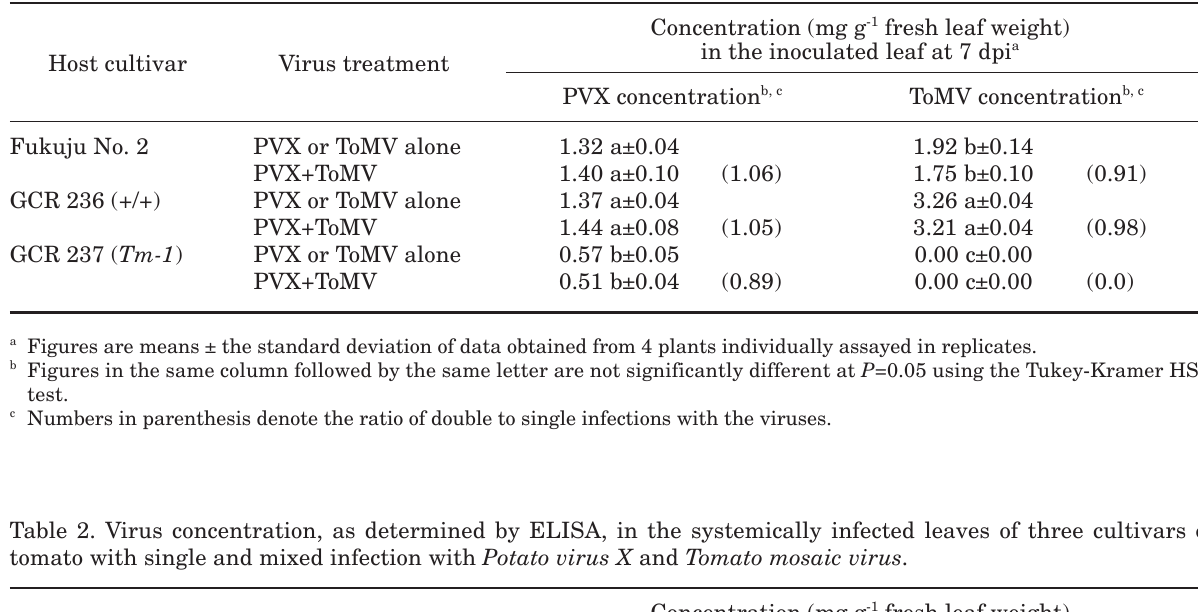
Table 1. Virus concentration, as determined by ELISA, in the inoculated leaves of three cultivars of tomato with single and mixed infection with Potato virus X and Tomato mosaic